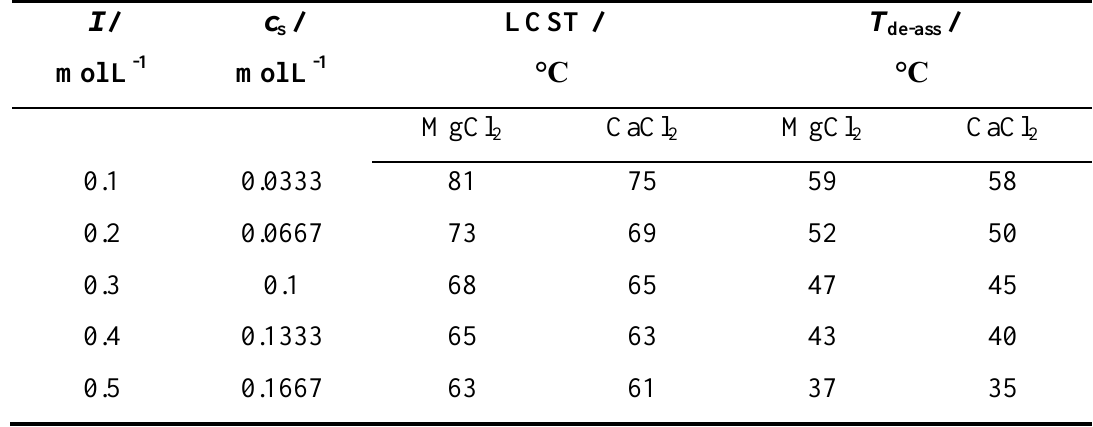
= 0.20) solutions in MgCl N